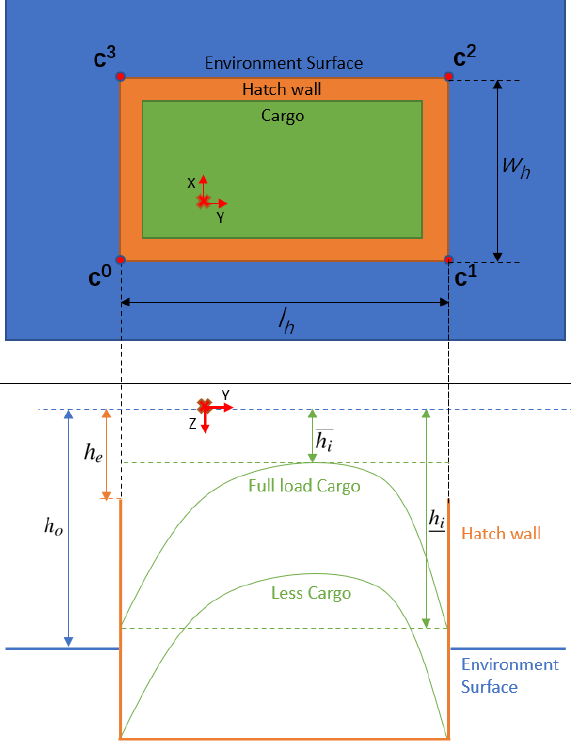
Figure 5. Schematic of a hatch containing cargo. ( Top ) View of the hatch along an vector pointing into the hatch (i.e., the P -frame z -axis). ( Bottom ) Side view depicting the y - z plane. The z -coordinate difference between the scanning system P -frame and nearest hatch edge (extracted from the point cloud) is denoted as h e . The z -coordinate difference between the scanning system P -frame and the environment surrounding the hatch is denoted as h o . The z -coordinate difference between the scanning system P -frame and the inner cargo highest point is denoted as h i . The z -coordinate difference between the scanning system P -frame and the inner cargo lowest point is denoted as h i . There are multiple possible scenarios for the hatch localization